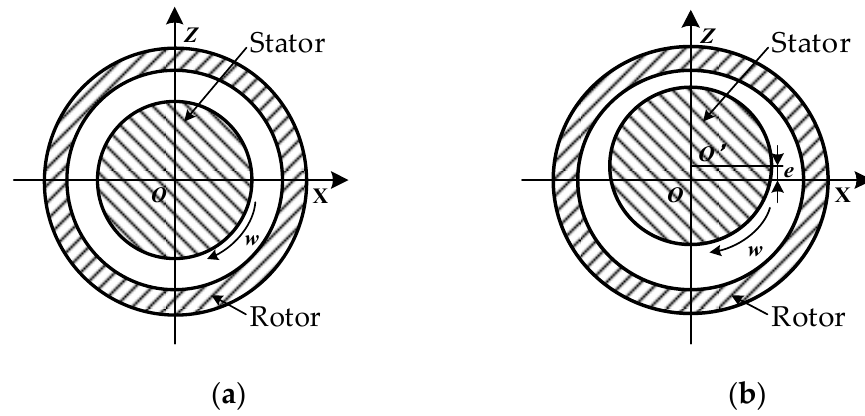
Figure 1. Eccentricity diagram of stator and rotor. ( a ) Noneccentricity. ( b ) Eccentricity. Finally, the vertical and longitudinal unbalanced electromagnetic forces caused by the eccentricity between the stator and rotor of the motor are calculated as follows: (cid:110)(cid:104) (cid:105) (cid:82) 2 π F ez = Lr B er ( r , α , t ) 2 − B et ( r , α , t ) 2 sin α + 2 [ B er ( r , α , t ) · B et ( r , α , t )] cos α 2 µ 0 0 where L is the axial length of the motor and µ 0 is vacuum permeability.